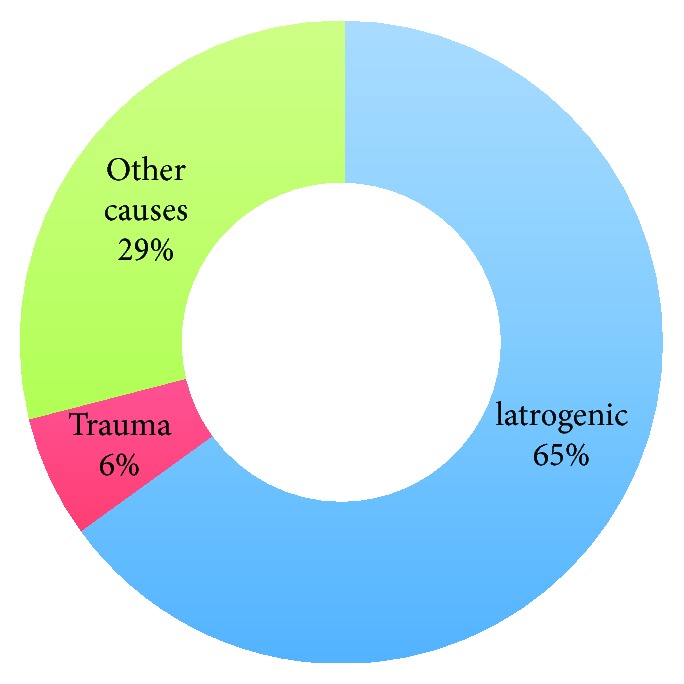
Common causes of hemobilia [6].